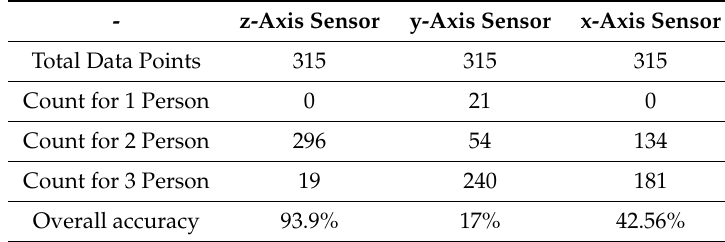
Table 1. Window size: two people sitting.